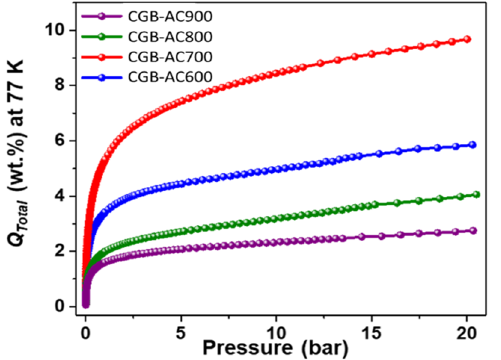
Figure 3. Total H 2 storage capacity of CGB-AC samples at 77 K and 20 bar. Based on Equation (1), CGB-AC700 had the highest Q total (9.67 wt.%) at 77 K and 20 bar. The high SSA and microporosity of the CGB-AC700 sample increased its H 2 storage capacity because of the higher number of H 2 adsorption sites. Similarly, the hydrogen uptake was lowest for CGB-AC900 (2.40 wt.%) because of its low porosity. Normally, the hydrogen adsorption capacity of activated carbons with high SSA tends to be in line with Chahine’s rule. Chahine’s rule is a typical trend obtained empirically where approximately 1 wt.% of gravimetric H 2 uptake is obtained for every 500 m 2 g − 1 of SSA at 77 K and elevated pressure up to ~350 bar [55,56]. Figure 4a displays Chahine’s line (solid) and the relationship between Q excess and SSA for CGB-AC samples. We found that CGB-AC800 and CGB-AC900 samples were closely related to the SSA while the others (CGB-AC600 and CGB-AC700) greatly outperformed at the trend. This exceptionally high H 2 uptake of CGB-AC600 and CGB-AC700 might be attributed to the high oxygen contents of 38.5% and 37.9%, respectively, on the carbon surfaces [40].